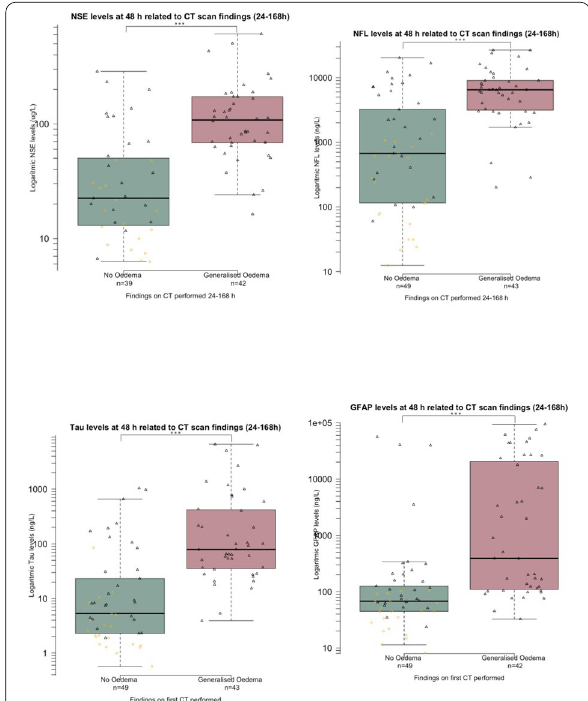
Fig. 1. CT scans performed 24–168 h post-arrest. Scatterplot indi- cate good neurological outcome presented as a yellow circle and defined as Cerebral Performance Category Scale [CPC] 1–2, poor outcome represented by a black triangle, defined as CPC 3–5